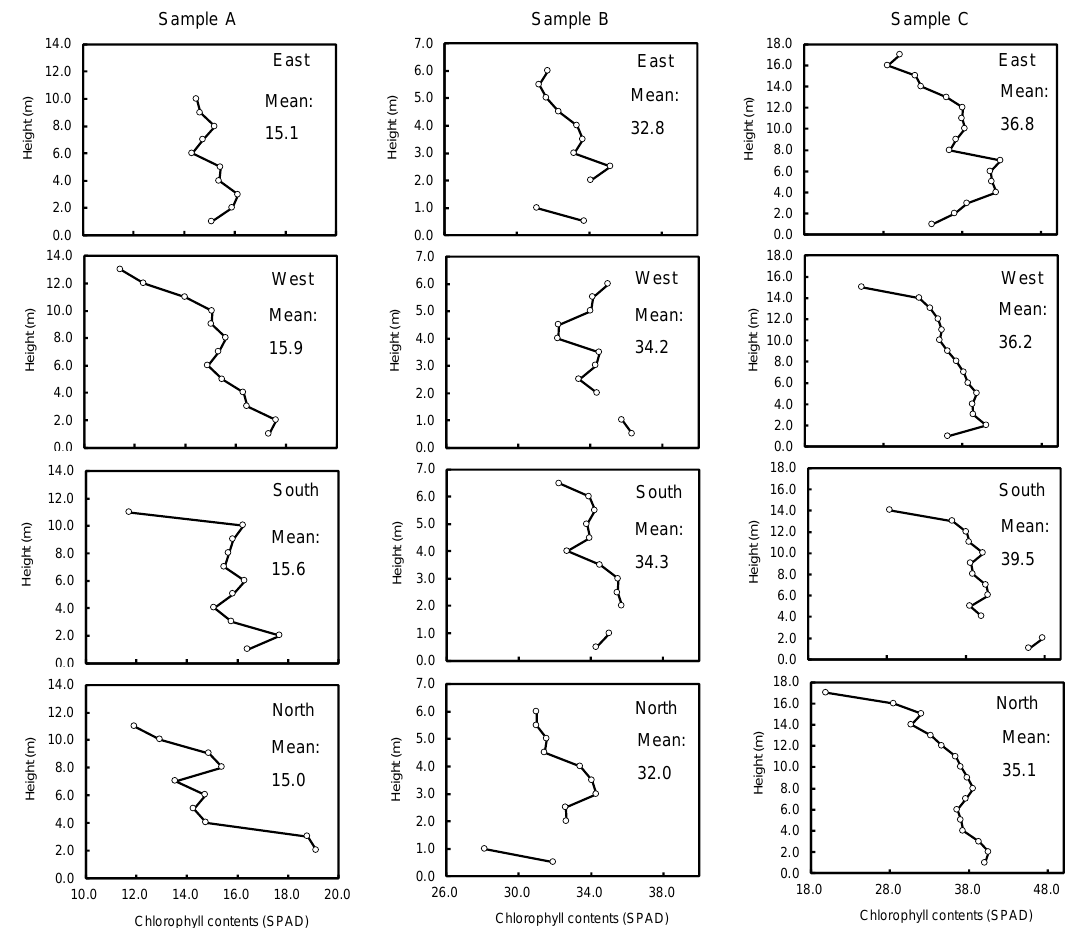
Figure 7. Vertical distributions of Chl contents of each region facing each orientation for each sample. The absence of a line in the profiles of samples B and C means that there were no leaves at those heights.